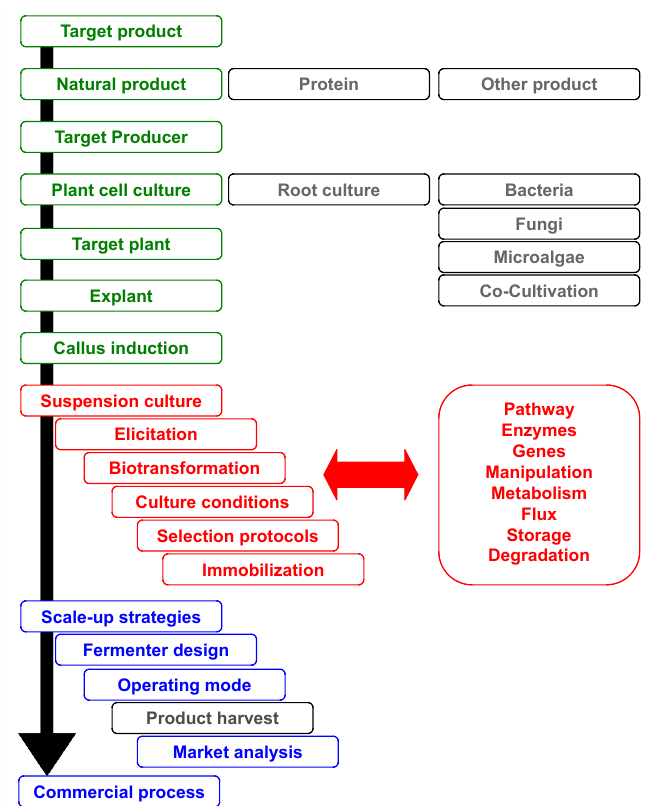
Fig. 1: Strategies for the alternative production of natural products (SNAPs). Special emphasis is only put on plant cell suspension cultures. The latest results gained from the cultivation of genetically transformed roots are not taken into account. The use of microorganisms, in- cluding microalgae, in the production of plant-borne SNAPs is not addressed in a comprehensive way here. Neither are methods for product isolation and release. Other products, like proteins, are not addressed in this review. The areas not reviewed in detail are shown in grey. Issues related to large-scale culture and commercialization are shown in blue. Methods using plant cell suspension cultures for pathway elucidation are shown in red. The black arrow indicates the path from a target product to an industrial process using plant cell suspension cultures. The arrow also defines the structure of this